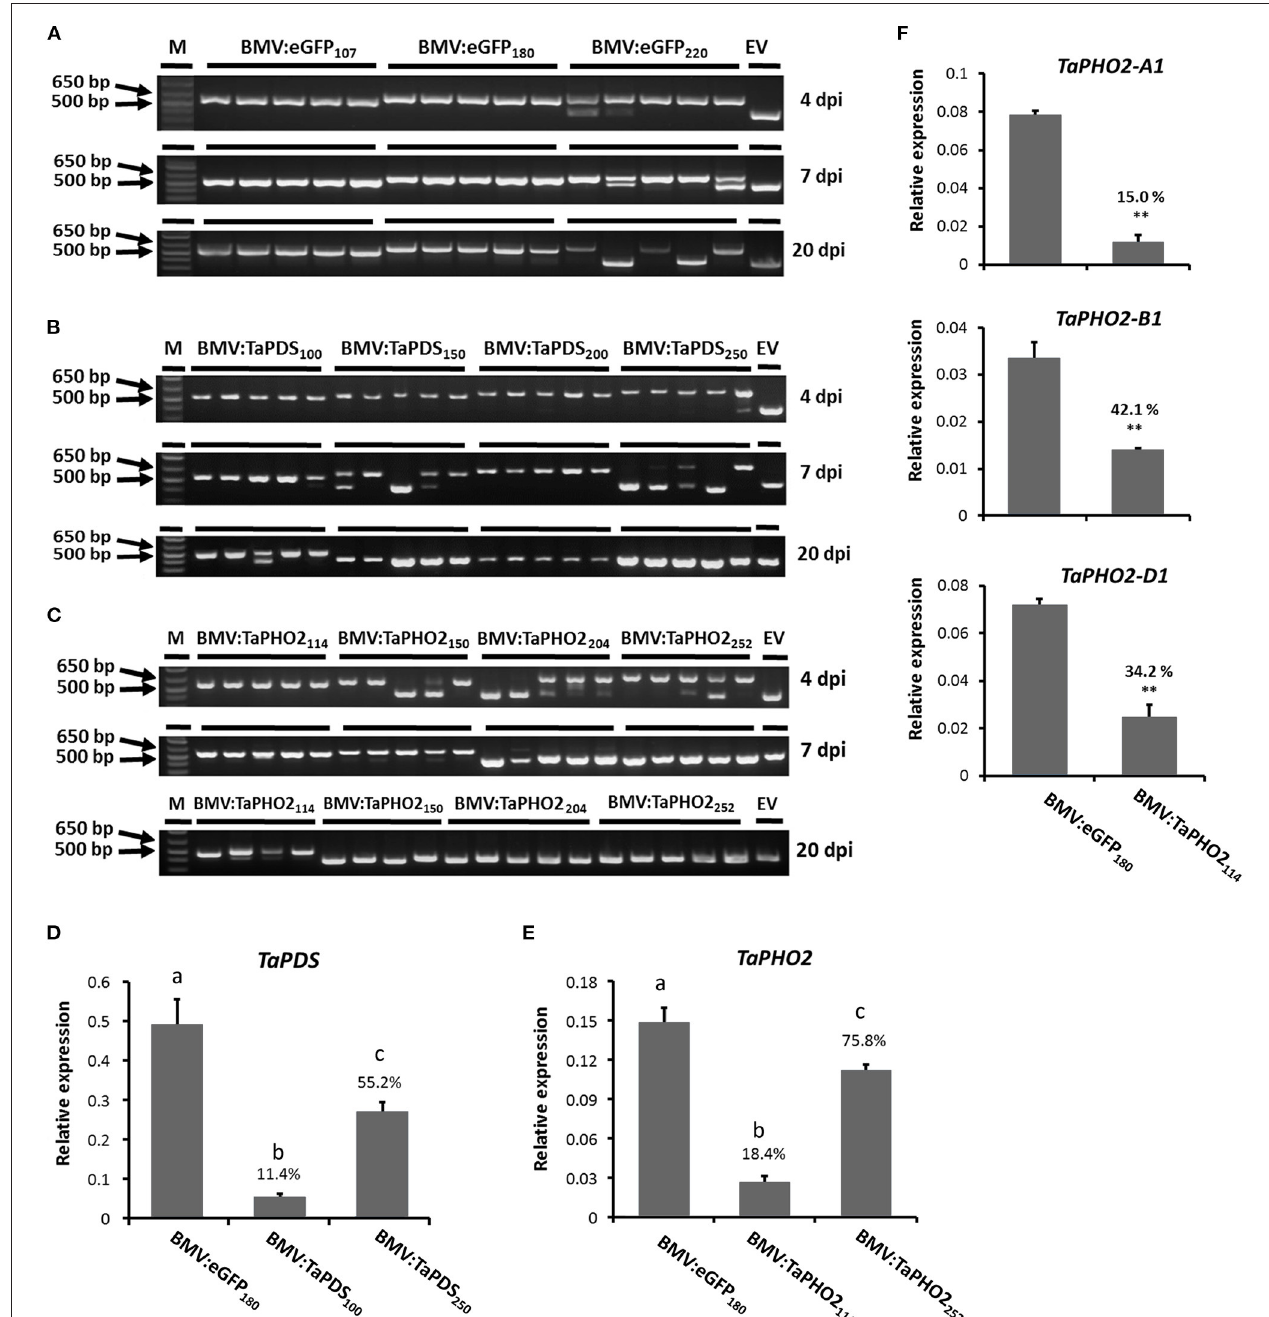
FIGURE 2 | Stability of insert fragments and gene silencing in wheat leaves with BMVCP5. RT-PCR products from wheat leaves of plants inoculated with BMVCP5 harboring gene fragments in length from 100 to 252 nt from eGFP (A) , TaPDS (B) , and TaPHO2 (C) . Subscript numbers after target gene designation indicate the insert size in the BMV vector. The 1st or 2nd inoculated leaf or 3rd systemic leaf were harvested, respectively, at 4, 7, and 20 dpi, and total RNA extracted for RT-PCR amplification using primers flanking the cloning site (P4-F/P4-R). Each lane represents an RT-PCR product from an individual plant. Similar results were obtained in three independent experiments. A 1kb plus DNA ladder (M, Invitrogen) and a 427-bp PCR product amplified from plasmid pC13/F3CP5 with no insert (EV) serve as size markers. (D–F) Relative expression levels of target gene mRNA in the 3rd systemic leaf at 20 dpi were determined by RT-qPCR using the same cDNA analyzed for insert stability in Panels (A–C) and primers specific for the host target mRNA (but not the relevant insert fragment). PCR product quantities for target genes were normalized against the levels of wheat translation elongation factor subunit EF1 α ( TaEF1 α ) mRNA. (D) Relative expression levels of TaPDS mRNA in plants infected with BMV:eGFP 180 , BMV:TaPDS 100 or BMV:TaPDS 250 . (E) Relative expression levels of TaPHO2 mRNA in plants infected with BMV:eGFP 180 , BMV:TaPHO2 114 or BMV:TaPHO2 252 . (F) Relative expression levels of TaPHO2-A1, TaPHO2-B1 , TaPHO2-D1 mRNA in plants infected with BMV:eGFP 180 or BMV:TaPHO2 114 .